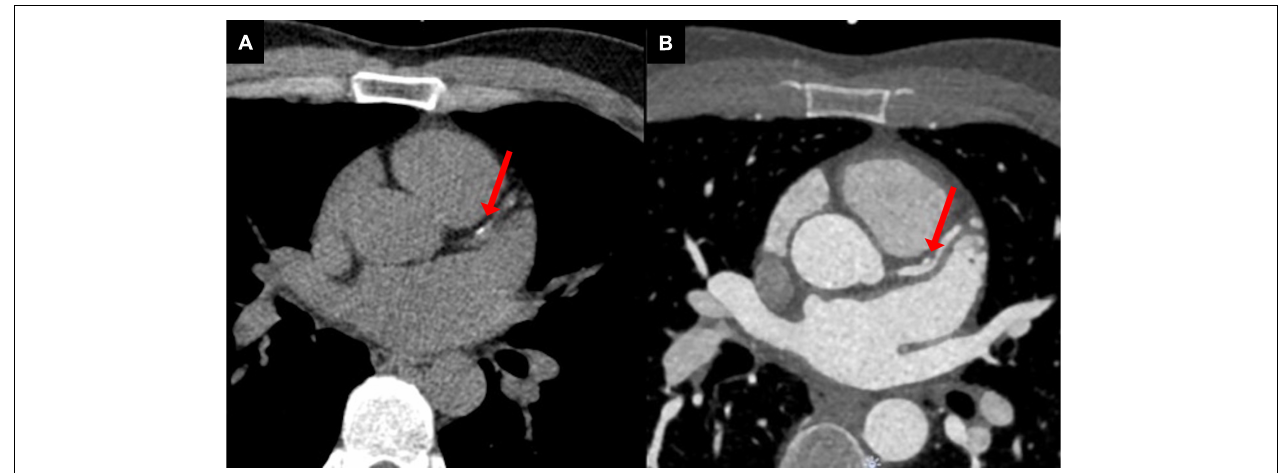
FIGURE 4 | Young patient treated with radiotherapy for Hodgkin lymphoma in childhood with premature atherosclerosis. (A) A non-contrast computed tomography scan, used for the assessment of coronary artery calcium score, showed calcinations in the proximal left anterior descending coronary artery (red arrow). (B) Coronary computed tomography angiography revealed a non-obstructive vulnerable plaque (red arrow).